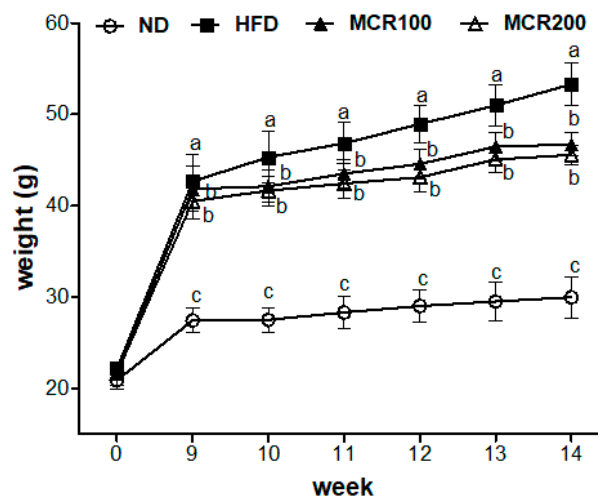
Figure 1. Effect of Mori Cortex radicis extract (MCR) on body weights of HFD-induced (High Fat Diet-Induced) mice. Mice were fed ND or HFD with or without MCR (100 or 200 mg/kg b.w.) for 14 weeks. Weights were monitored weekly. Results are presented as means ± SDs ( n = 8). Statistical significance was accepted for p values < 0.05. Small letters indicate significantly different from other groups.